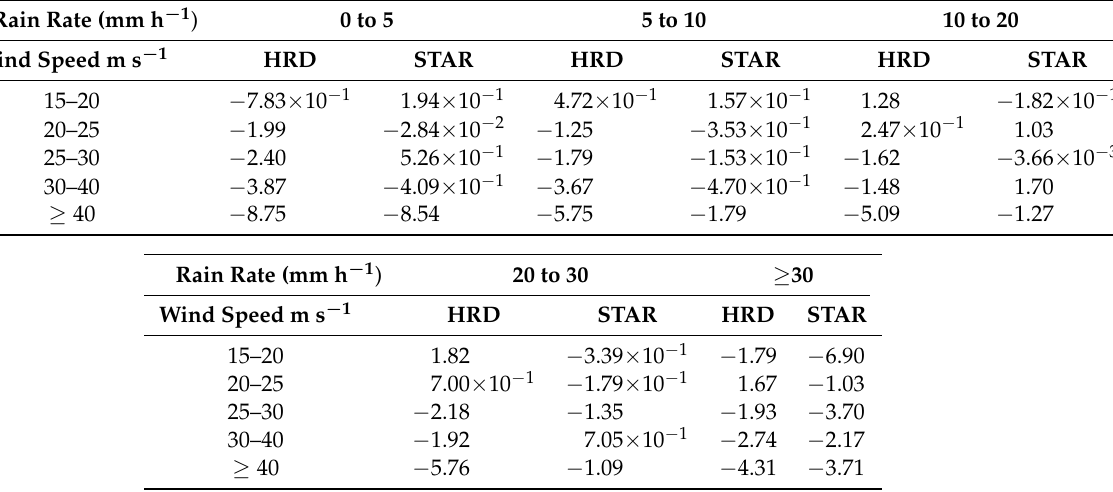
Table 6. Wind-Speed Retrieval Error Means for the HRD and STAR Algorithms.